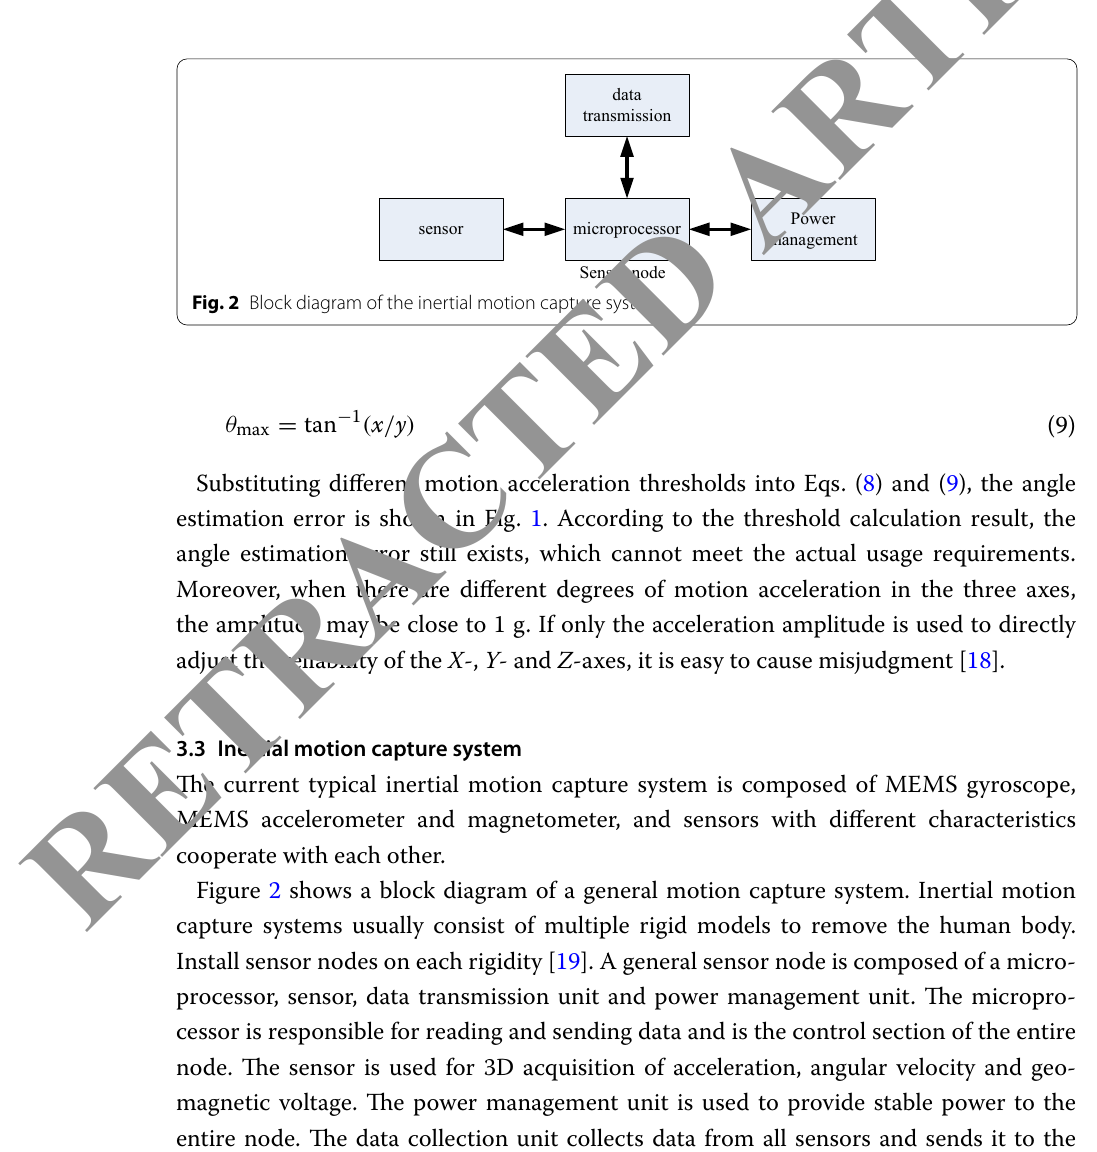
Fig. 1 Angle estimation error of threshold judgment